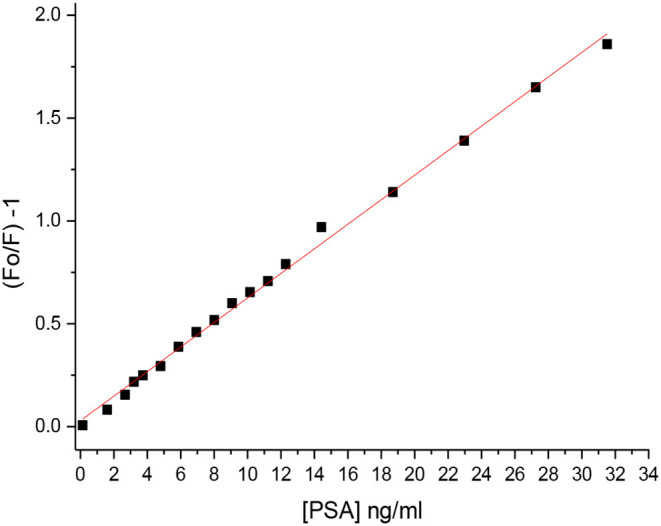
Stern–Völmer plot.